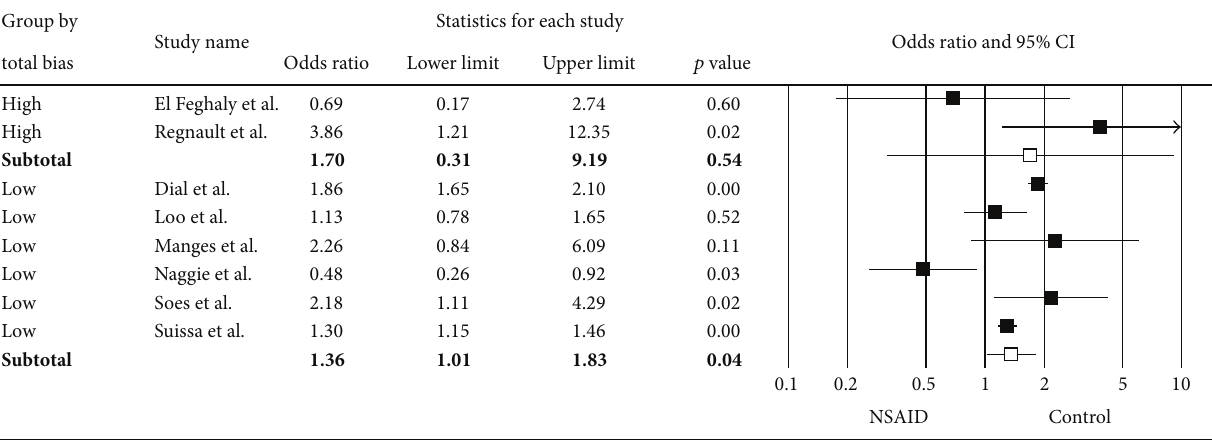
Figure 4: Forest plot of subgroup analysis by risk of bias.